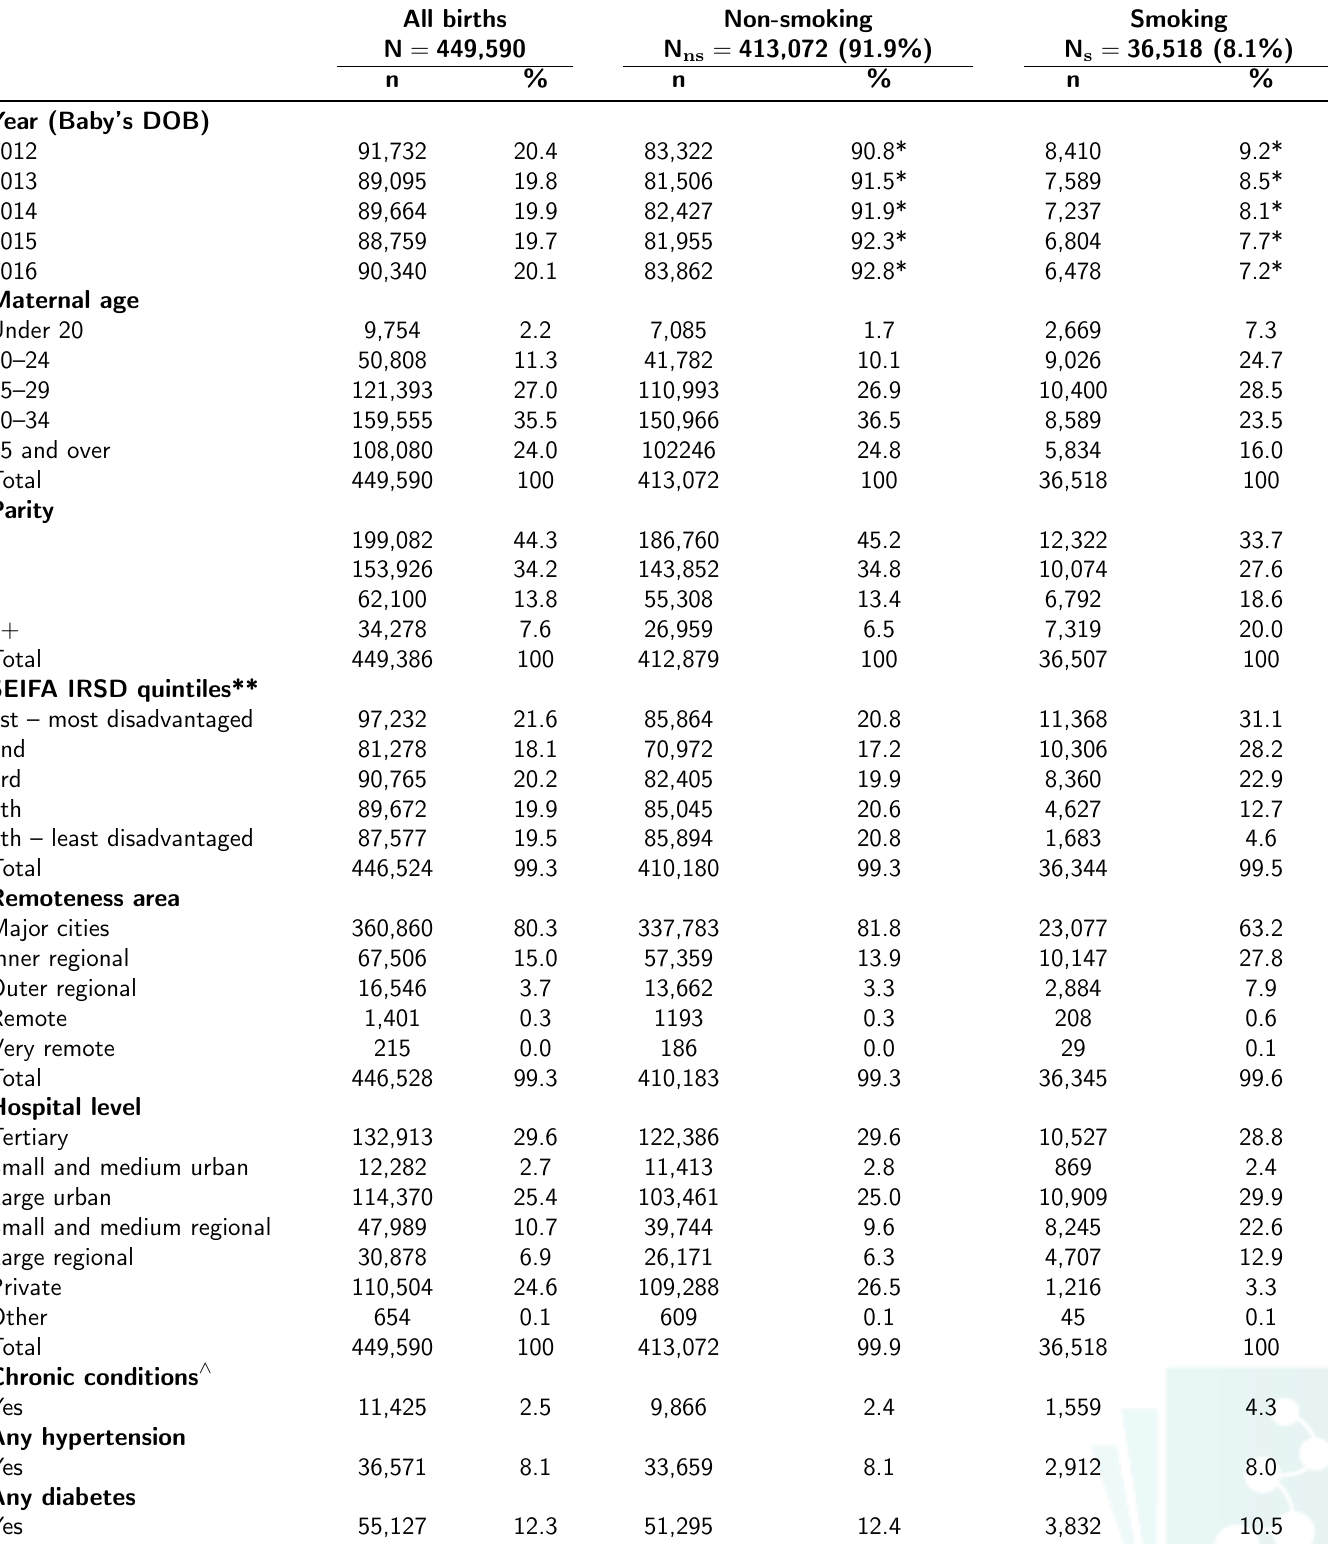
Table 1: Demographics at the time of birth of mothers who gave birth to at least one singleton baby in NSW between 2012 and 2016 reported for all births and by smoking status during pregnancy All